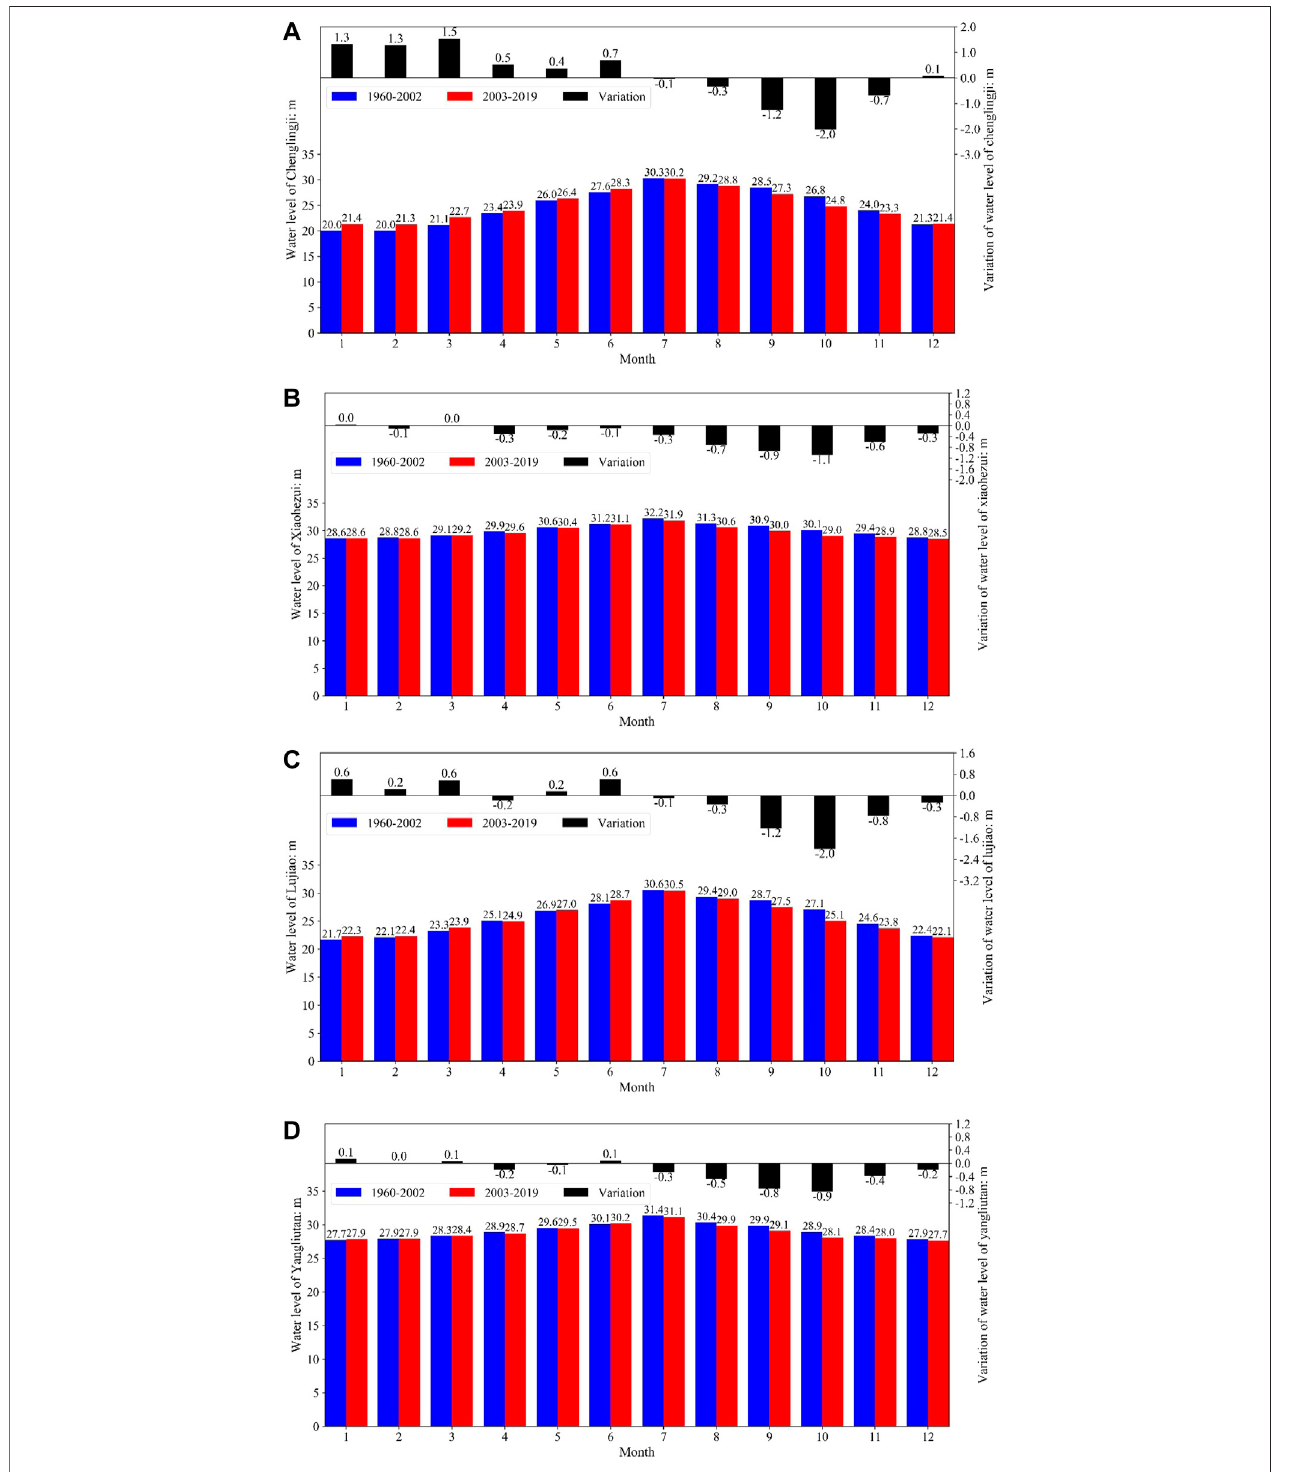
FIGURE 9 | Variations of water levels at different time periods at the (A) Yangtze River at Chenglingji, (B) Xiaohezui, (C) Lujiao, and (D) Yangliutan stations. The dotted lines in each fi gure is the fi tted trend line.